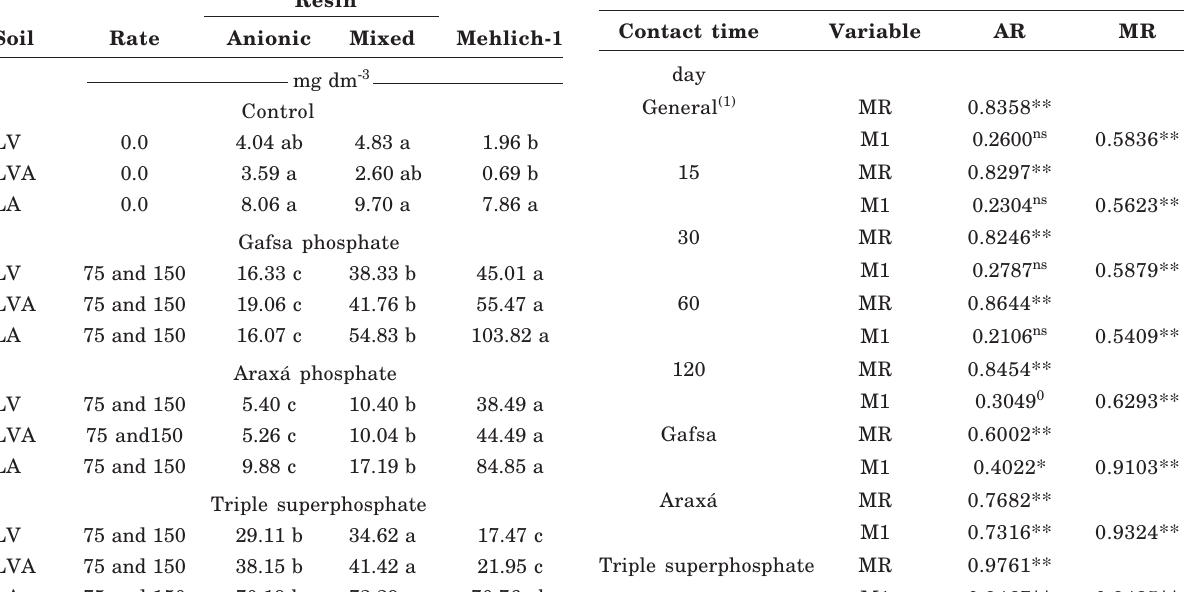
Table 8. Matrix of the general correlation between extractors (Anionic resin - AR, Mixed resin - MR and Mehlich-1 - M1) within each contact time for the means of soils, sources and P rates, and within each source, for the means of the contact times, soils and P